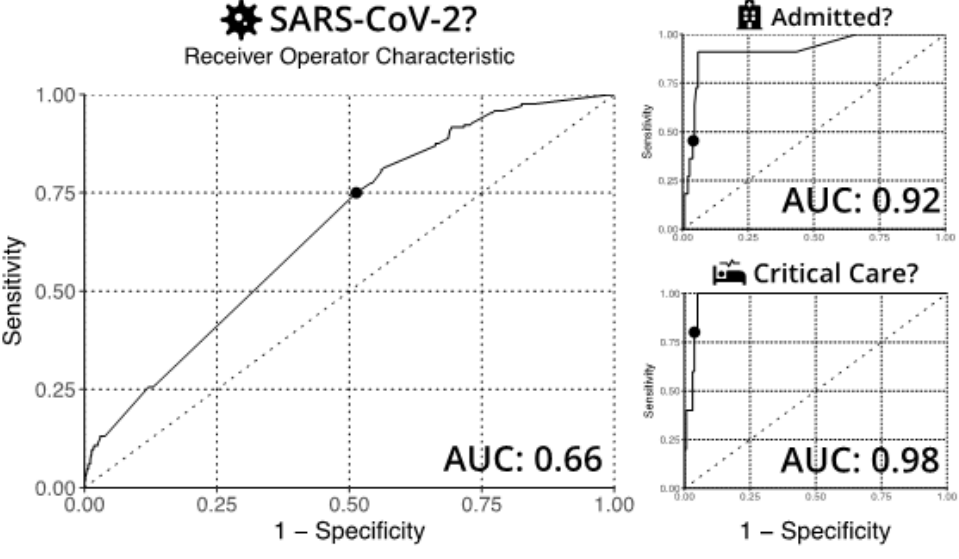
Figure 4. Receiver operator characteristic curves for the best-encountered model for predicting SARS-CoV-2 test results (gradient boosting, left), hospital admissions for patients who are SARS-CoV-2 positive (random forest, top right), and critical care admissions for patients who are SARS-CoV-2 positive (support vector machine, bottom right). Numbers in the bottom right of each subgraph show the respective model's AUC. Solid dots on the curves indicate operating thresholds selected on the validation fold. AUC: Area under the receiver operator characteristic